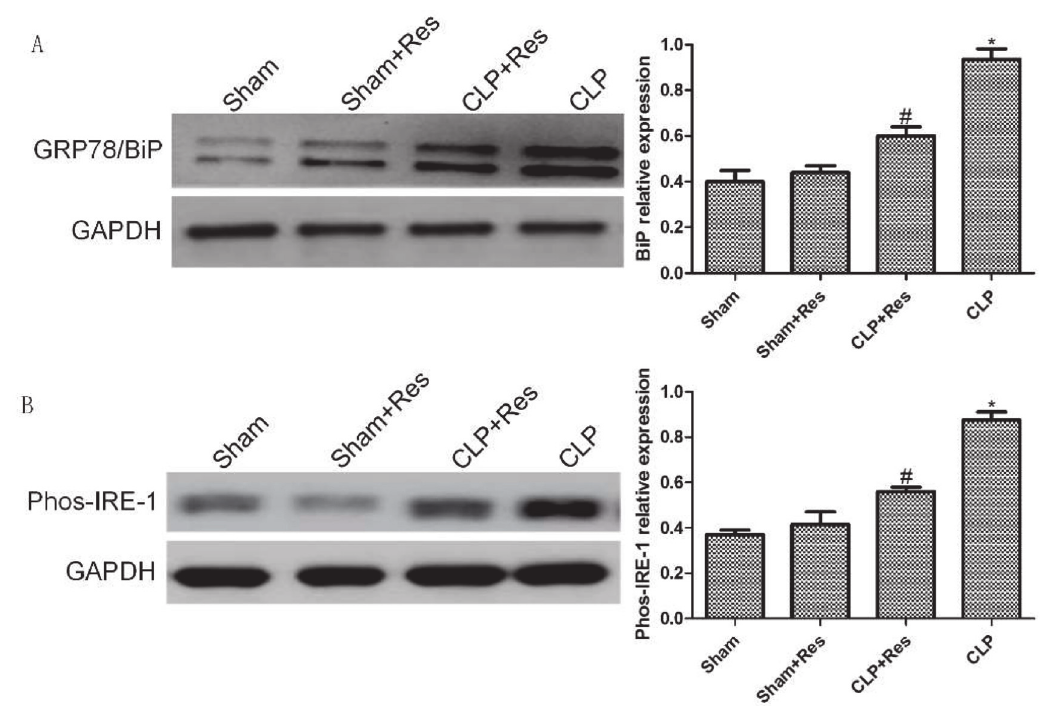
Fig. 4. Effects of resveratrol on (A) BiP and (B) phosphorylated IRE1 protein expressions in kidney tissues of septic rats. *Compared with Sham group, P <0.05; #compared with CLP group, P <0.05.